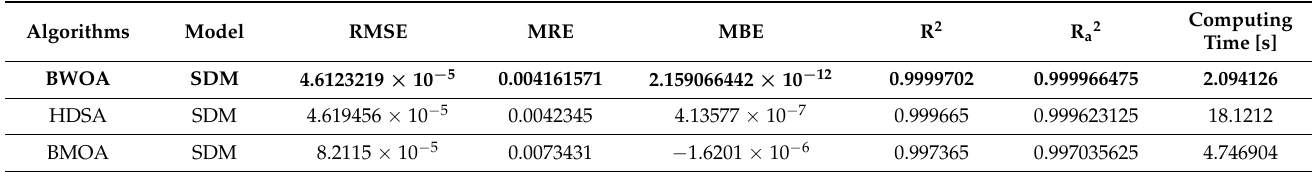
Table 5. Statistical tests of the aSi photovoltaic cell for different